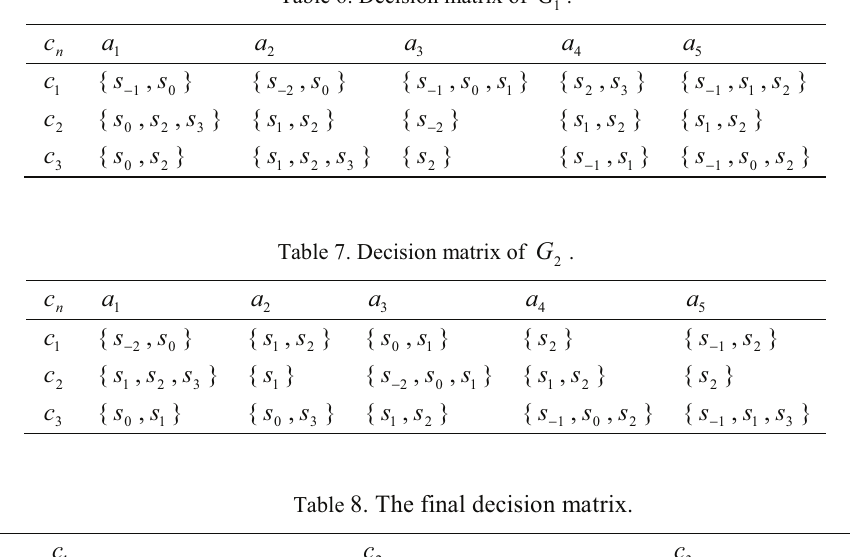
Table 6. Decision matrix of